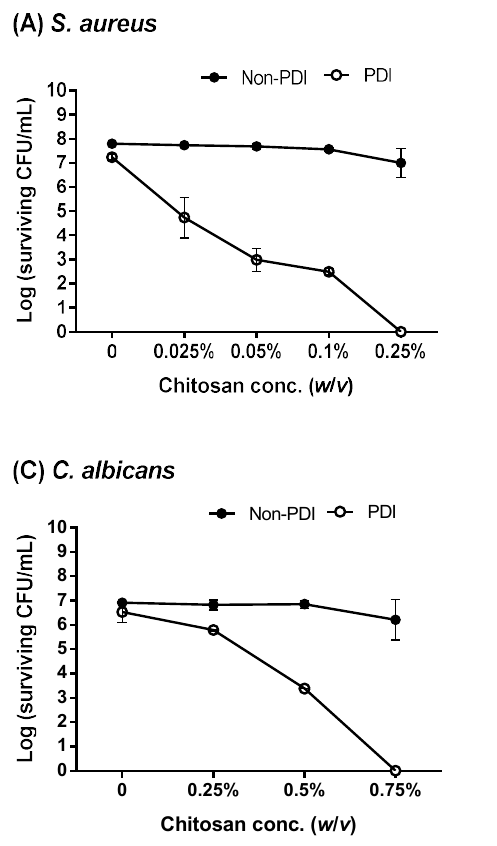
Figure 4. Increases in chitosan concentration could enhance the killing ability against microbial cells. Planktonic cells of ( A ) S. aureus , ( B ) P. aeruginosa , and ( C ) C. albicans subjected with TBO-mediated PDI were then incubated with different concentrations of chitosan for 30 min. For PDI, 10 µ M TBO was used in S. aureus and P. aeruginosa . For C. albicans , 100 µ M TBO was used. After light irradiation (50 J cm − 2 ), cells were further incubated with different concentrations of chitosan as indicated for 30 min. Each value is the mean obtained from three independent experiments ± SD.